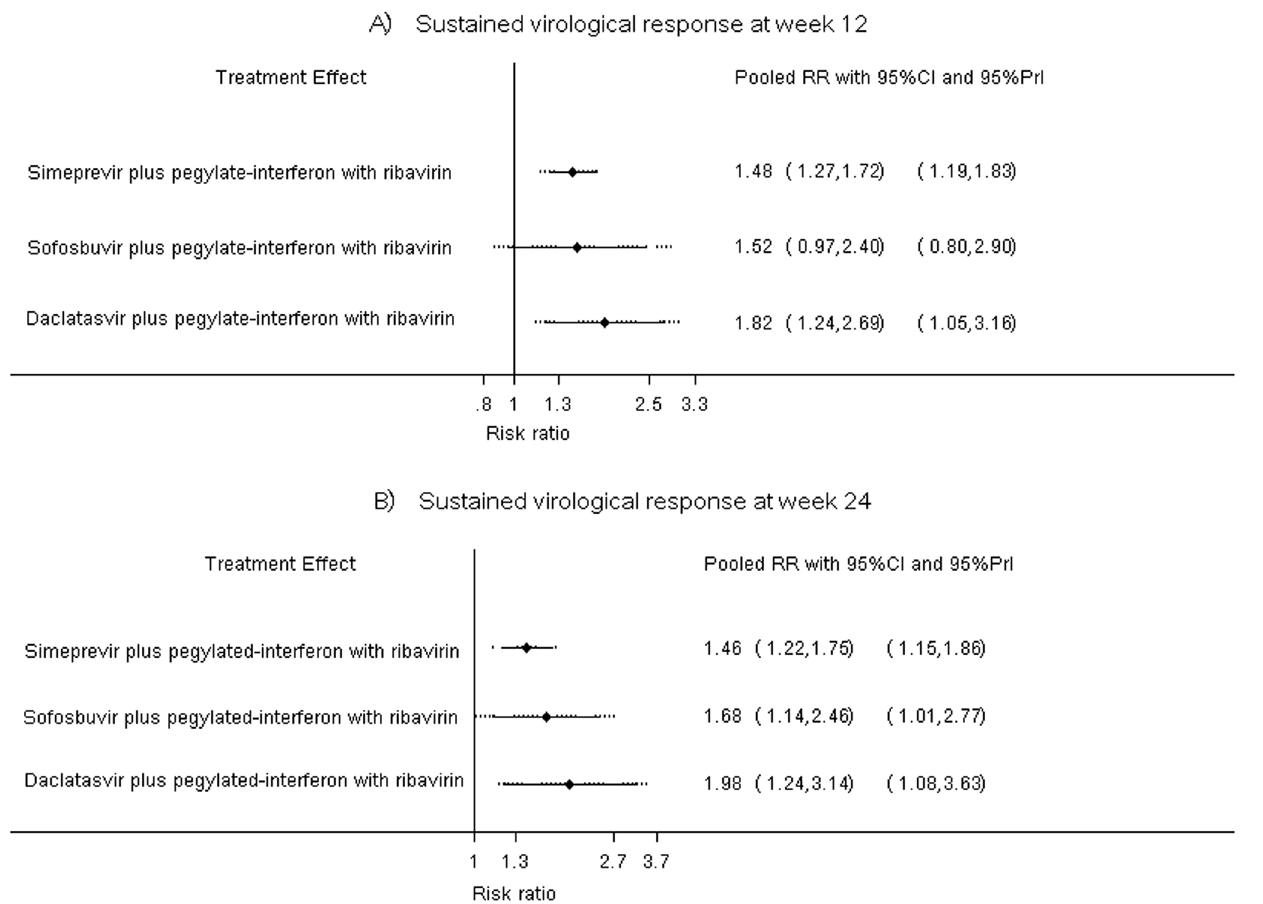
Fig 3. Predictive interval plots for sustained virological response at weeks 12 and 24 after the end of